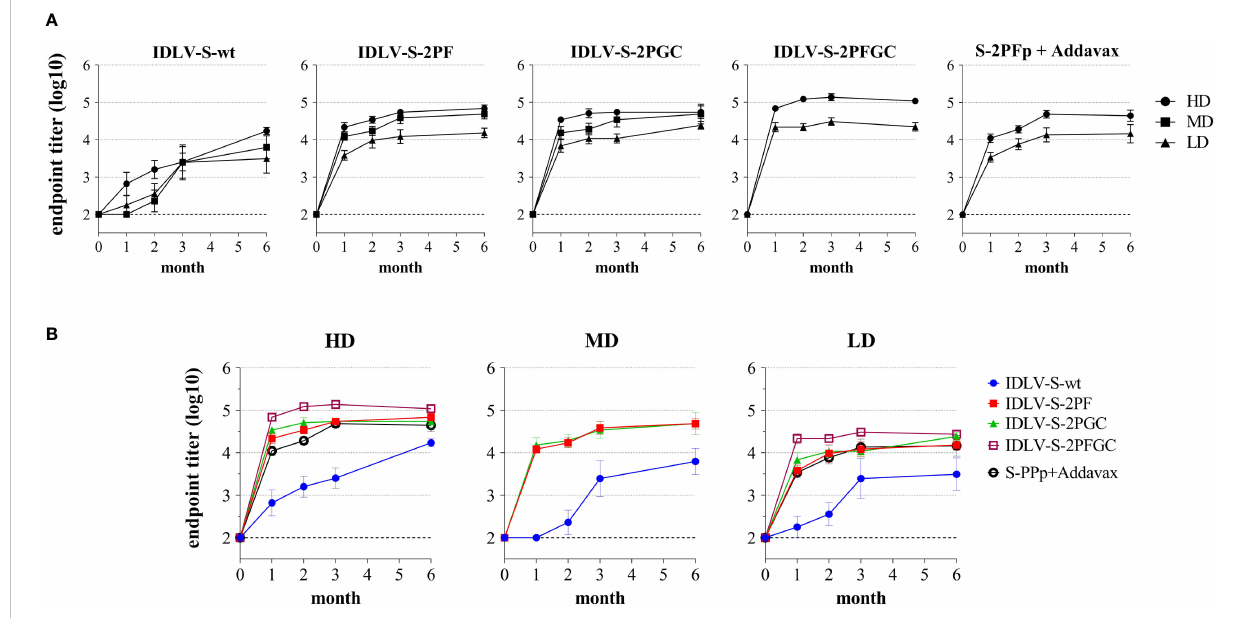
FIGURE 3 Kinetics of anti-RBD binding antibodies in immunized mice. BALB/c mice (N=5-6 animals per group) were vaccinated once with escalating doses (High dose, HD: 25x10 6 ; Medium dose, MD: 6.25x10 6 ; Low Dose, LD: 1.56x10 6 RT units/mouse) of SIV-based IDLVs expressing Spike or HD and LD of the puri fi ed Spike protein (10 and 1 µg/mouse) adjuvanted with Addavax. Anti-RBD IgG antibodies were evaluated at different time points (month) from immunization in sera of mice immunized with the indicated vaccines. Results are expressed as log10 mean endpoint titer ± SEM. The dotted line indicates the assay cut off (minimum serum dilution tested 1:100). (A) Each graph shows the results from mice of the same vaccine group at HD, MD and LD. (B) Each graph shows different vaccine groups at the same